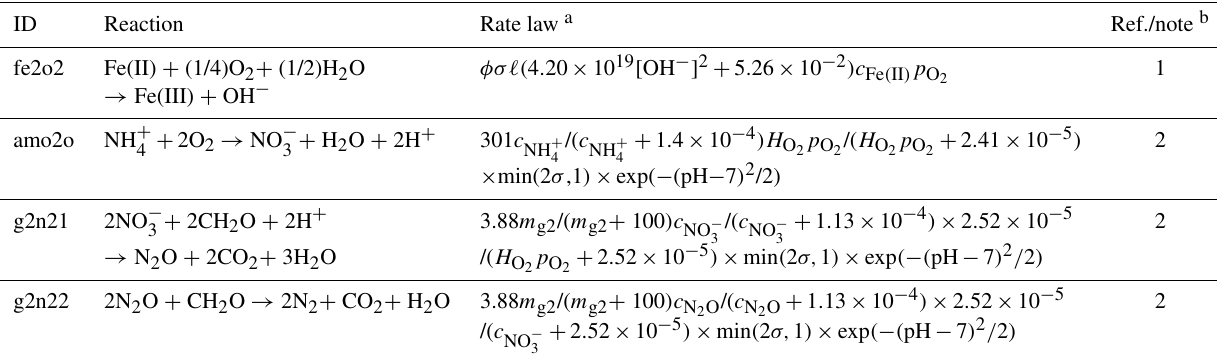
Table 6. Extra reactions and their kinetic laws. ID Reaction Rate law a Ref./note b fe2o2 Fe(II) + (1/4)O 2 + (1/2)H 2